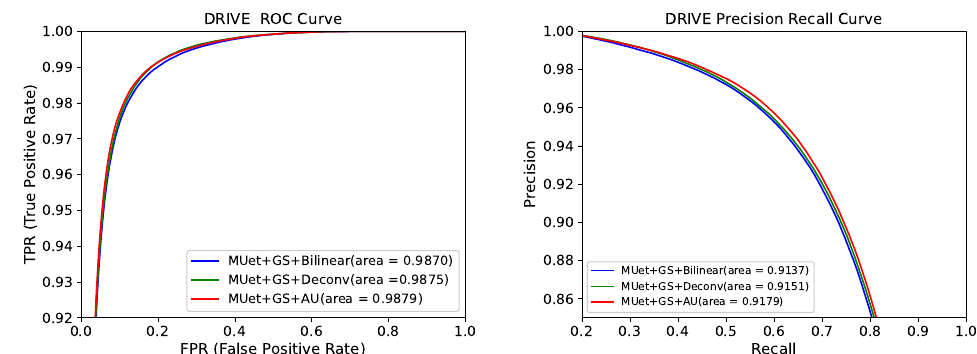
Figure 4. Receiver operating characteristic (ROC) curve and precision recall (PR) curve for five models on the CHASE dataset.